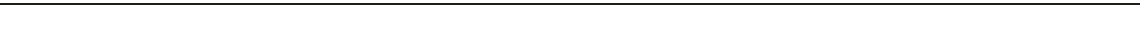
Fig. 5 α -GalCer-mediated amelioration of arthritis is partially dependent on IFN- γ production by iNKT cells. a Top, mean clinical score of anti-IFN- γ -treated and isotype-control-treated WT mice that received α -GalCer or vehicle alone following induction of arthritis. The Y axis shows the percentage of swelling in antigen-injected knee compared to control knee. Bottom, bar chart showing the suppression of knee swelling in anti-IFN- γ -treated and isotype-control- treated WT mice that received α -GalCer, compared to anti-IFN- γ -treated and isotype-control-treated WT mice that received vehicle alone (anti-IFN- γ - treated WT ± α -GalCer n = 5 per group, isotype-control-treated WT ± α -GalCer n = 4 per group, one of two experiments is shown). b Representative fl ow cytometry plots (top) and bar charts (bottom) showing the frequency and number of splenic IFN- γ + and IL-17 + CD4 + T cells in anti-IFN- γ -treated and isotype-control-treated WT mice that received α -GalCer or vehicle alone ( n = 3 per group, one of two experiments is shown). c Representative fl ow cytometry plots (top) and bar charts (bottom) showing the frequency of T-bet + , ROR- γ t + , and GATA3 + CD4 + T cells in μ MT and WT splenocyte cultures with α -GalCer and isotype control or α -GalCer and anti-IFN- γ -blocking antibodies ( μ MT n = 3, WT n = 6, one of two experiments is shown). d Representative fl ow cytometry plots (top) and bar chart (bottom) showing the frequency of IFN- γ + CD4 + T cells following coculture with in vivo α -GalCer- stimulated iNKT cells (or alone), isolated from the spleens of arthritic μ MT and WT mice in the presence of IFN- γ -neutralizing or isotype-control antibodies ( n = 4 per condition, one of two experiments is shown). e Bar charts showing the frequency of T-bet + (left) and ROR- γ t + (right) CD4 + T cells, isolated from the spleens of arthritic WT mice, following stimulation with increasing concentrations of IFN- γ ( n = 3 per condition, one of two experiments is shown). b Analyzed on day 3 post disease onset. Data are mean ± s.e.m. ns not signi fi cant, * p < 0.05, ** p < 0.01, *** p < 0.001, and **** p < 0.0001 ( a